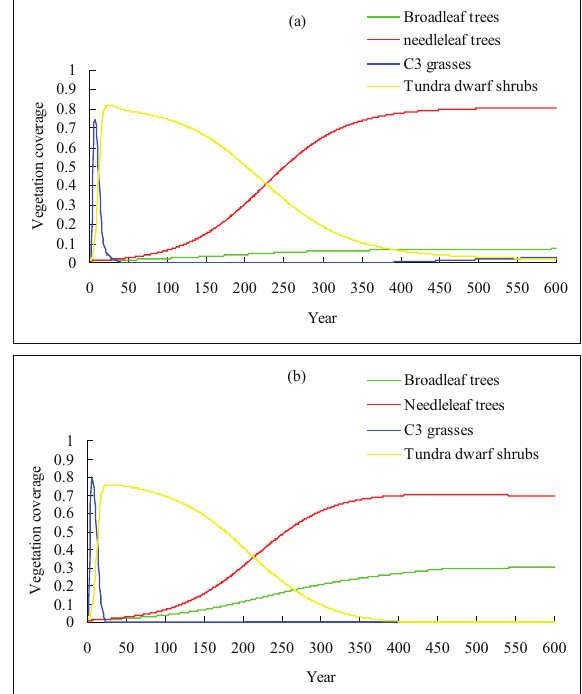
Figure 2. Temporal evolution of vegetation fractions. Results of experiments: (a) T; and (b) [T+5, (1+40%)P]